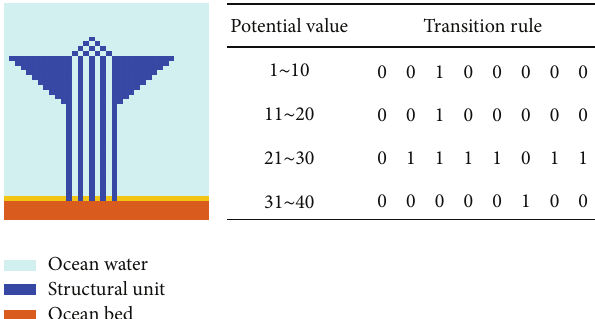
Figure 7: One calculation result. This transition rule emerged in “tower” like shape.